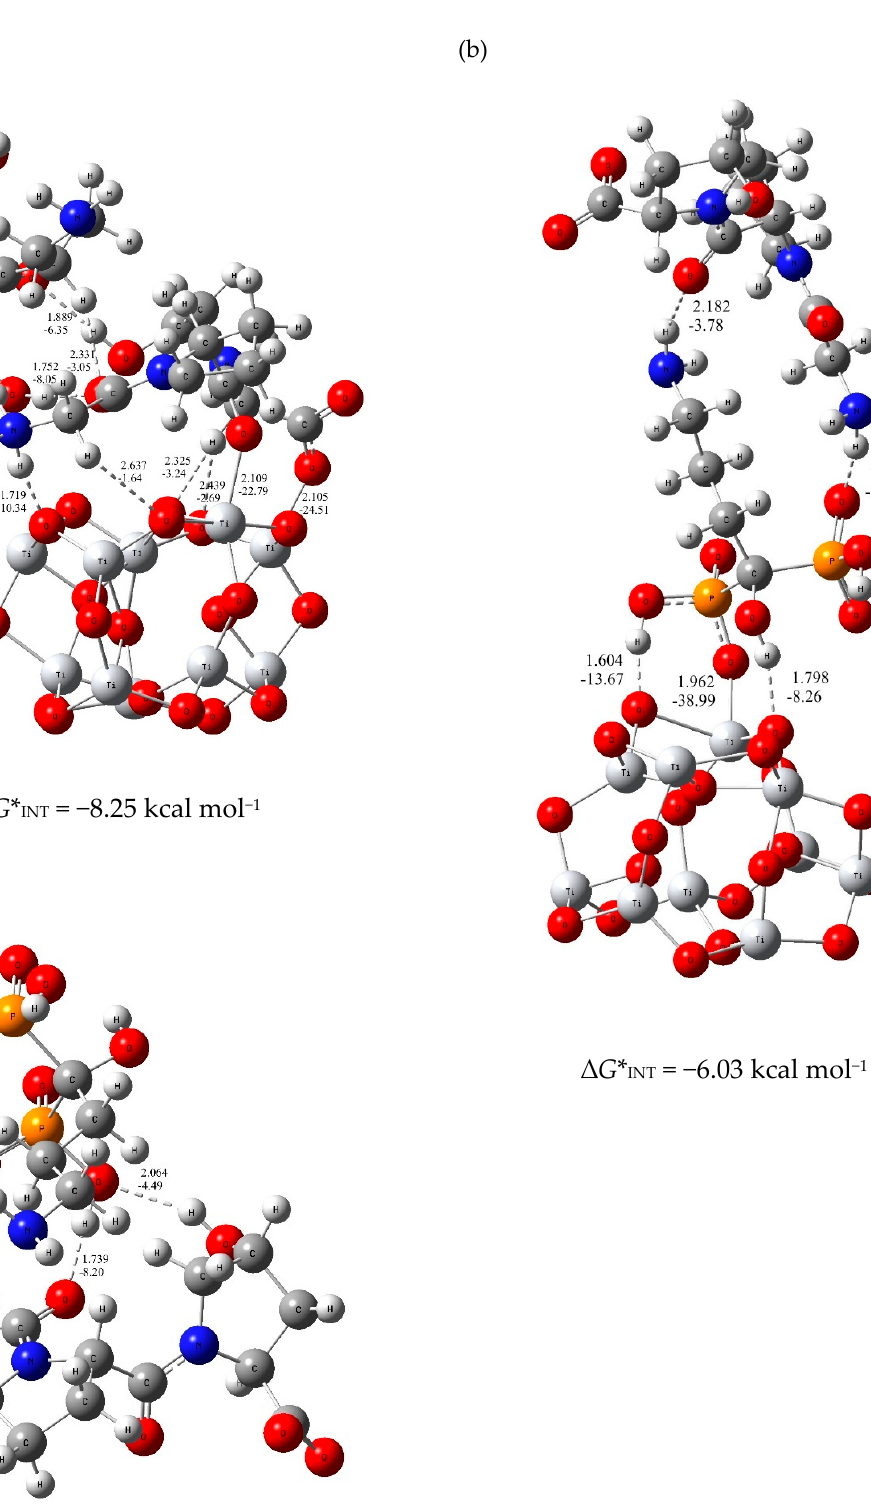
Figure 5. The most stable structures, predicted by DFT for ( a ) (TiO 2 ) 10 ─ alendronate ─ tripeptide, ( b ) (TiO 2 ) 10 –alendronate–tripeptide, and ( c ) starting tripeptide–alendronate structure. Bond distances in Å and bond energies in kcal mol − 1 . Oxygen—red ball; Nitrogen—blue ball; Phosphorus—orange ball; Titanium—light grey